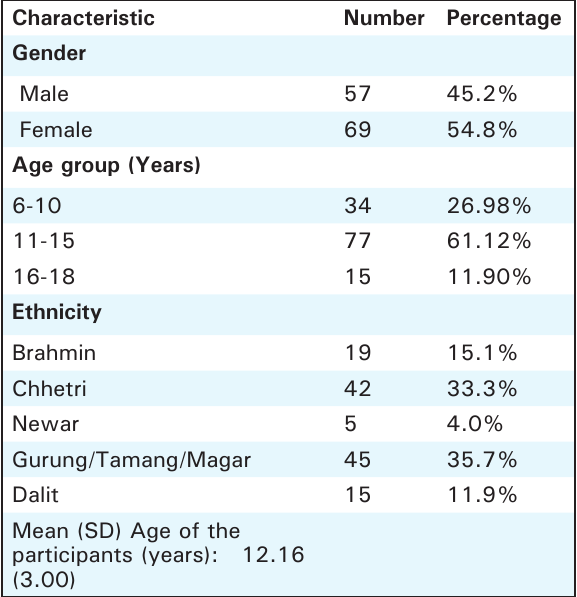
Table 1. Socio demographic characteristics of the participants